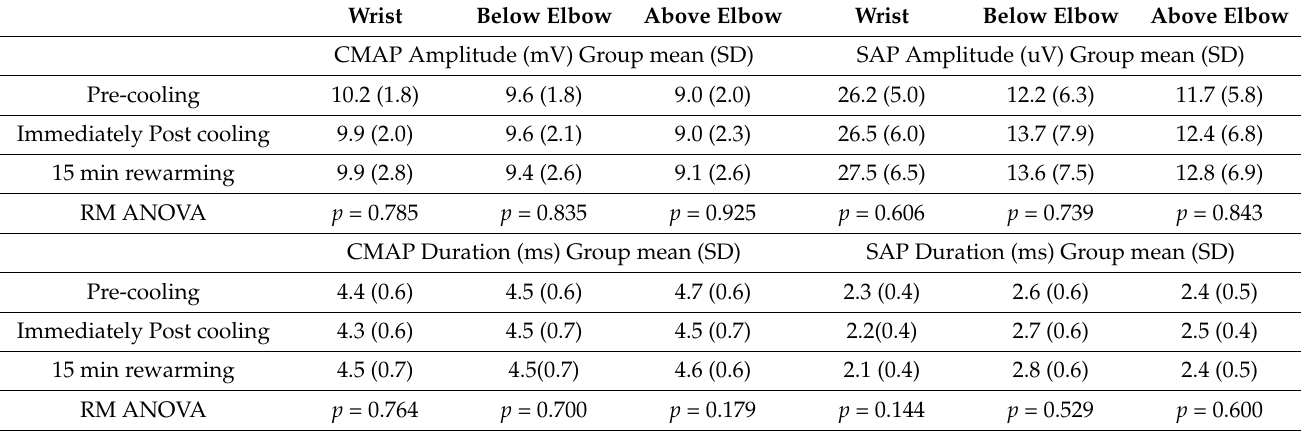
Table 2. Descriptive statistics and RM ANOVA for CMAP or SAP amplitudes and